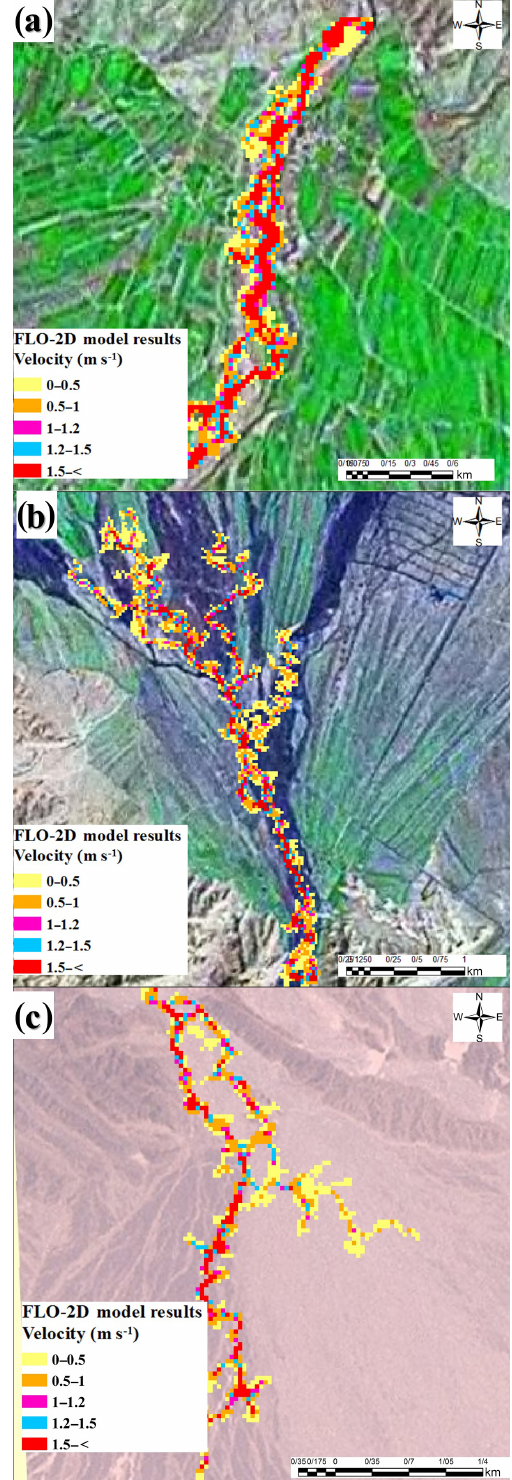
Figure 9. Flood velocities results of the FLO-2D model for the (a) Ferizy, (b) Ardak, and (c) Sarbaz